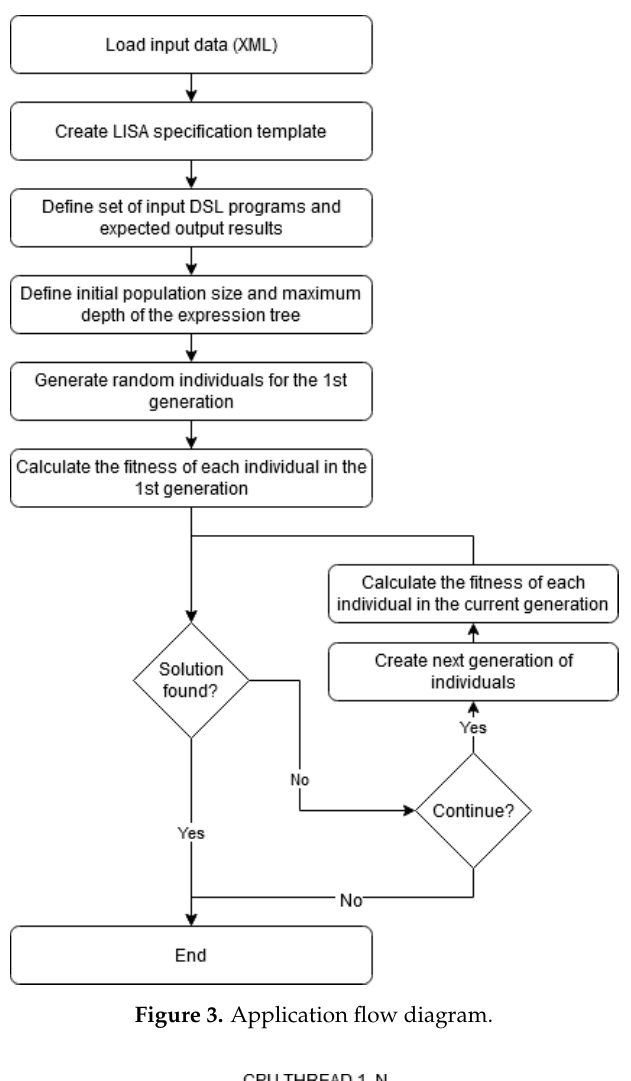
Figure 3. Application flow diagram.